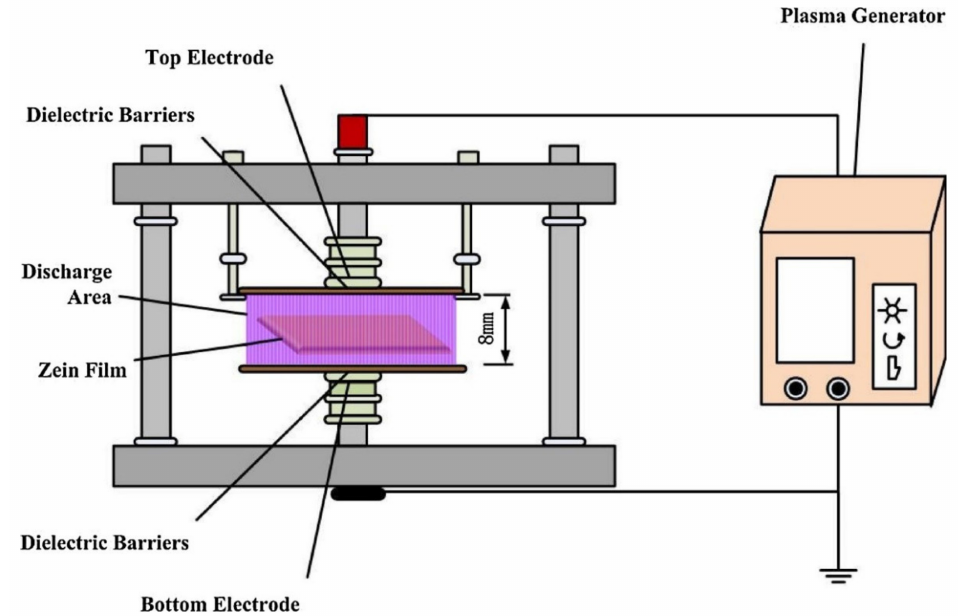
Figure 4. Representation of the experimental setup for treatment of zein films with ACP. Reprinted with permission from ref. [43]. Copyright Elsevier